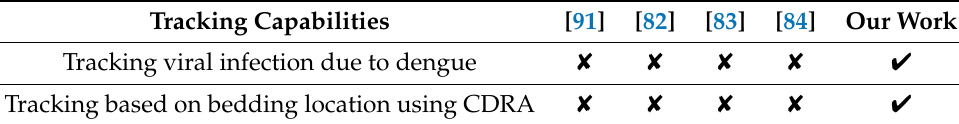
Table 9. Comparison of proposed